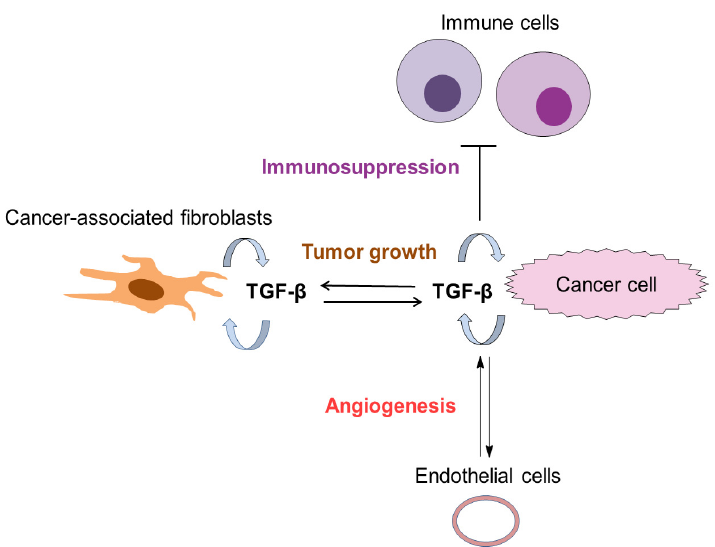
Figure 4. TGF- β signaling and the tumor microenvironment. TGF- β is expressed by cancer and stromal cells including cancer-associated fibroblasts (CAFs). TGF- β can maintain tumor progression by activating CAFs, stimulating immunosuppression, and promoting angiogenesis.